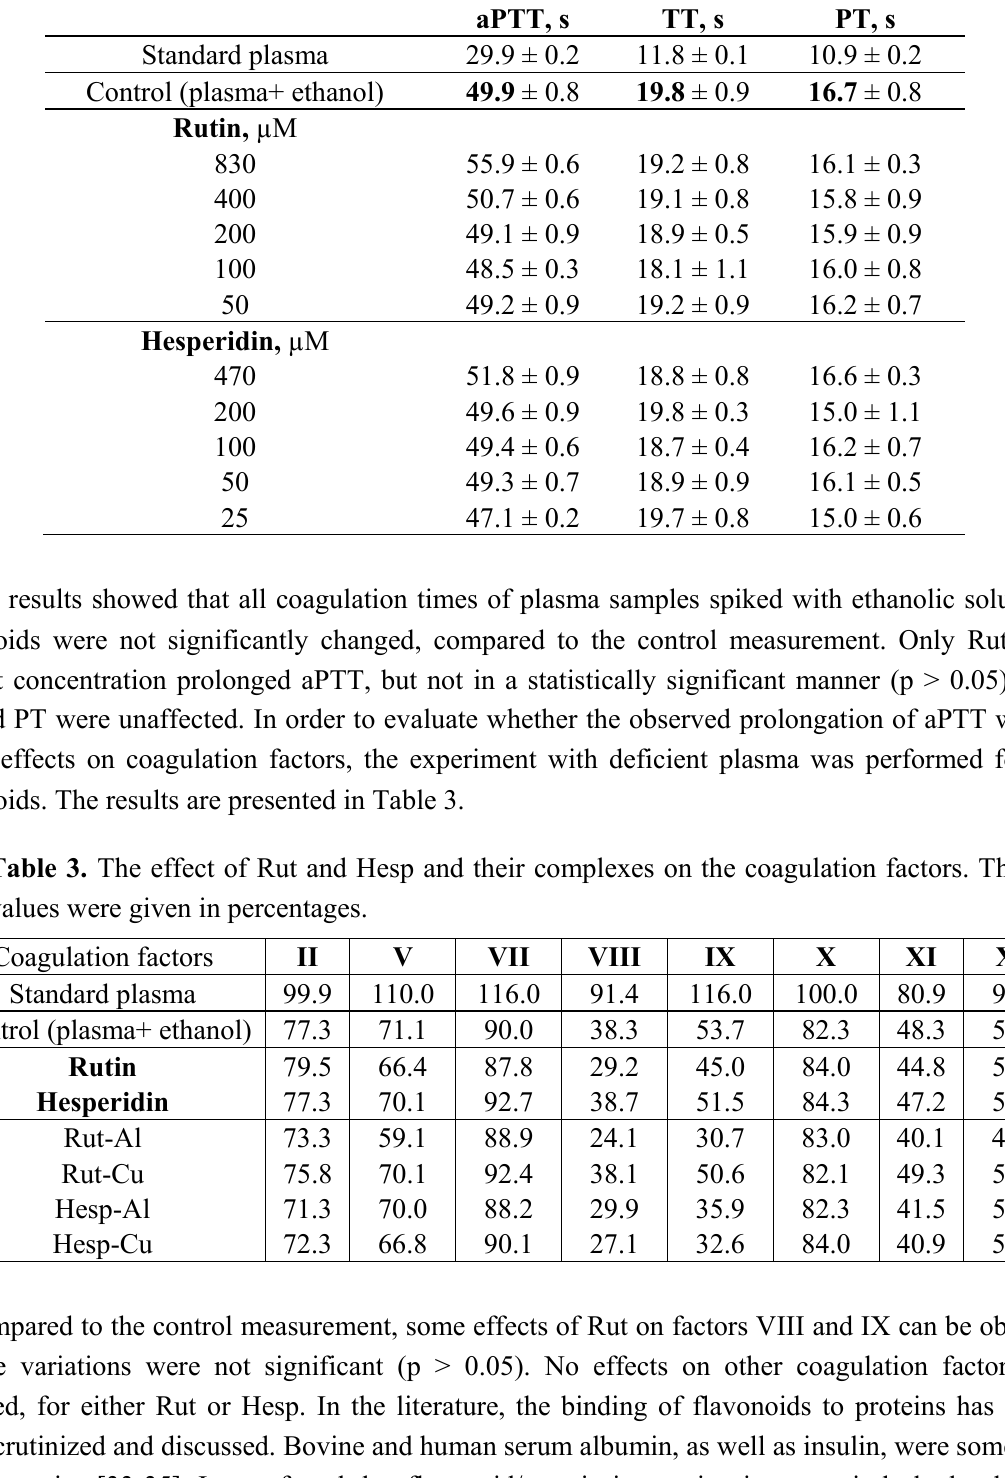
Table 2. The effect of Rut and Hesp in 16.6% ethanolic solution on coagulation times. The